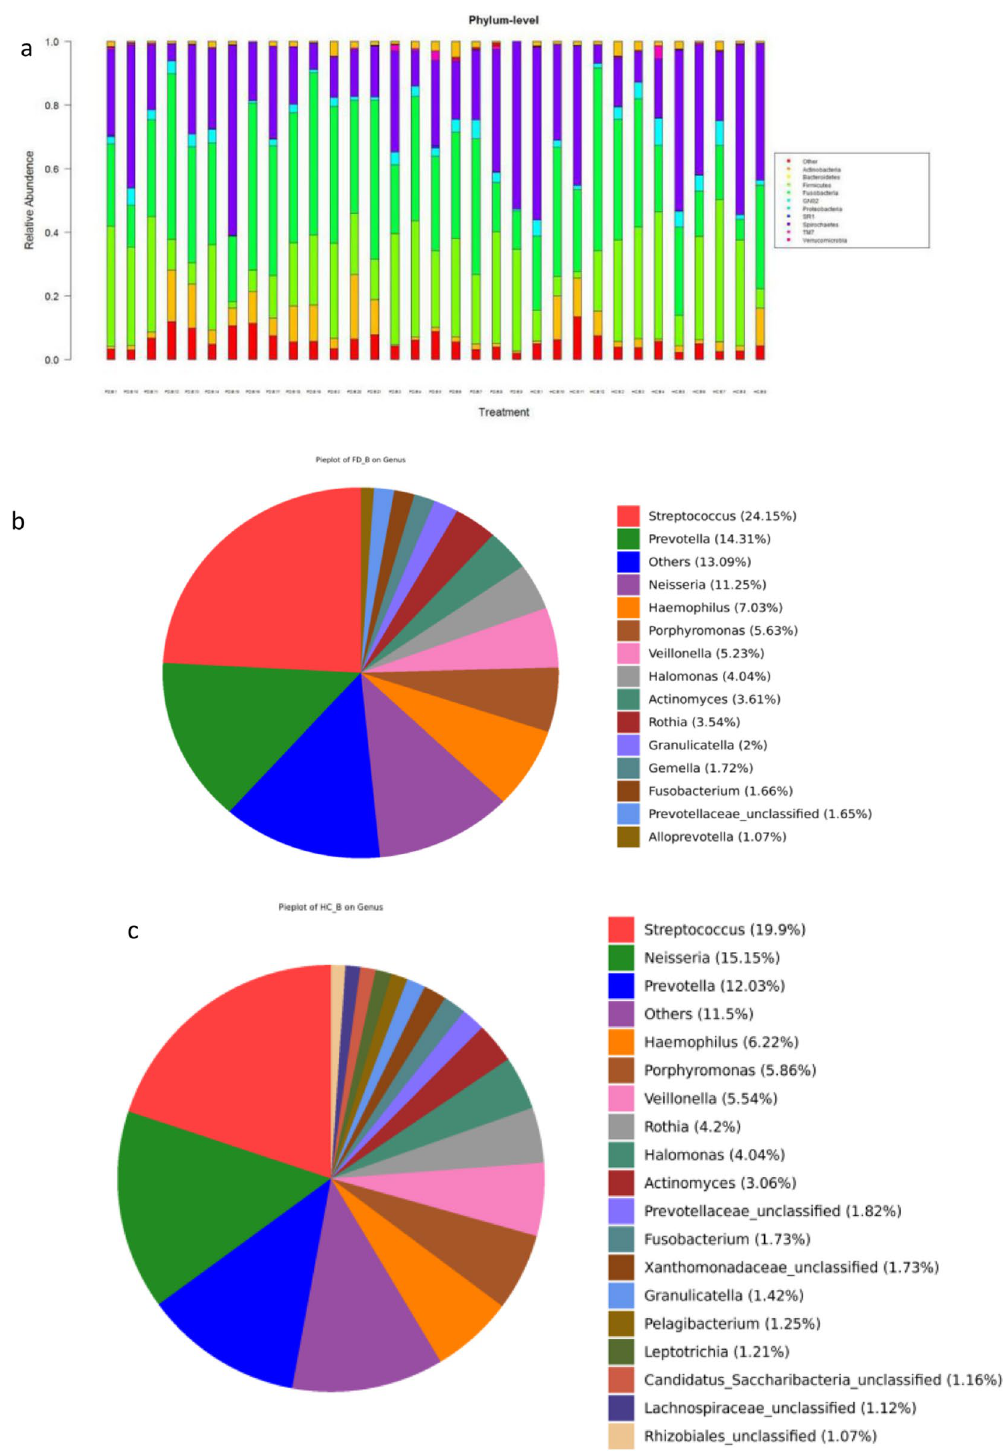
Figure 1. Relative abundance of saliva microbiota in FD patients and HCs. ( a ) Bar plots of relative abundance of phylum-level microbiota in the FD group and HC group. ( b ) Bar plots of relative abundance of genus-level microbiota in the FD group and HC group. ( c ) Relative abundance of genus-level microbiota in HCs. ( d ) Heatmaps showing the expression profile of genus-level